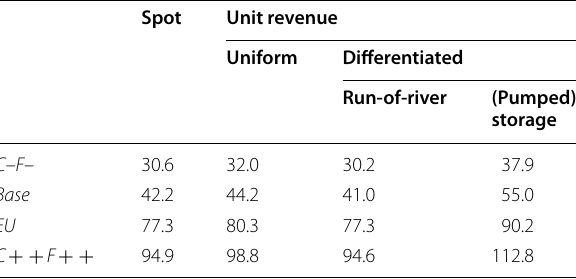
Table 2 Average spot market price and unit revenues in